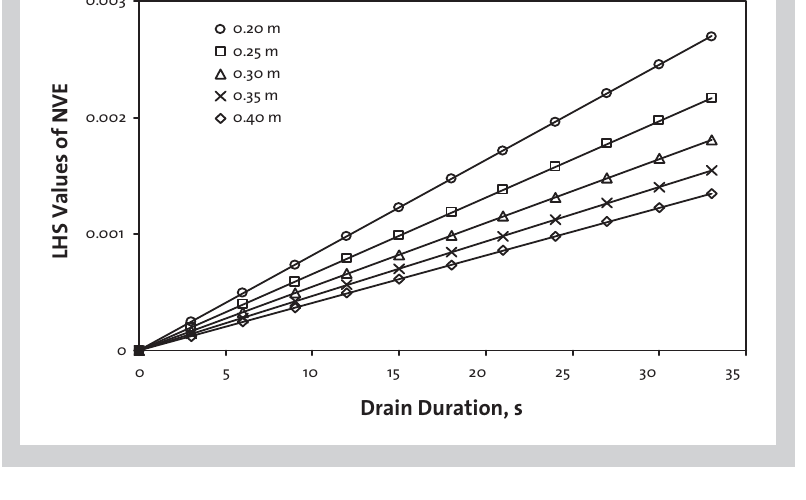
Figure 12: Shear stress versus shear rate for the 0.5 wt% PEO aqueous solution at 294 - 306